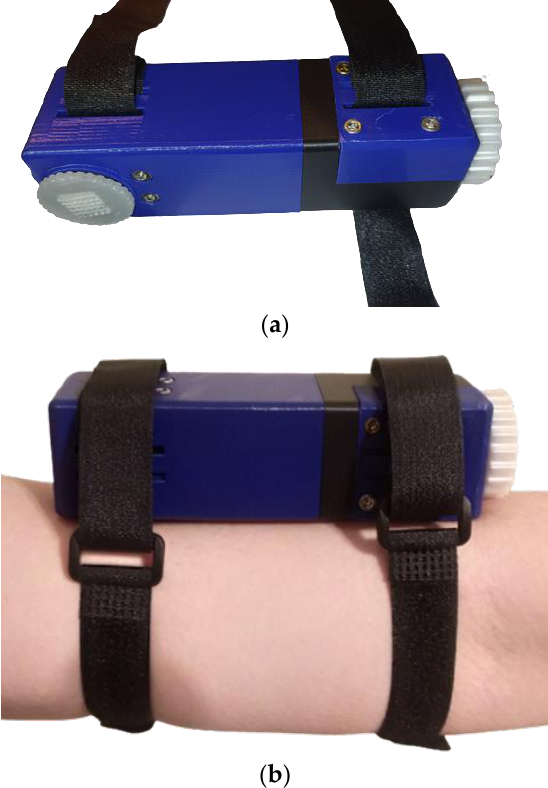
Figure 16. ( a ) Demonstration of the drug delivery apparatus, ( b ) the device attached to the hand of